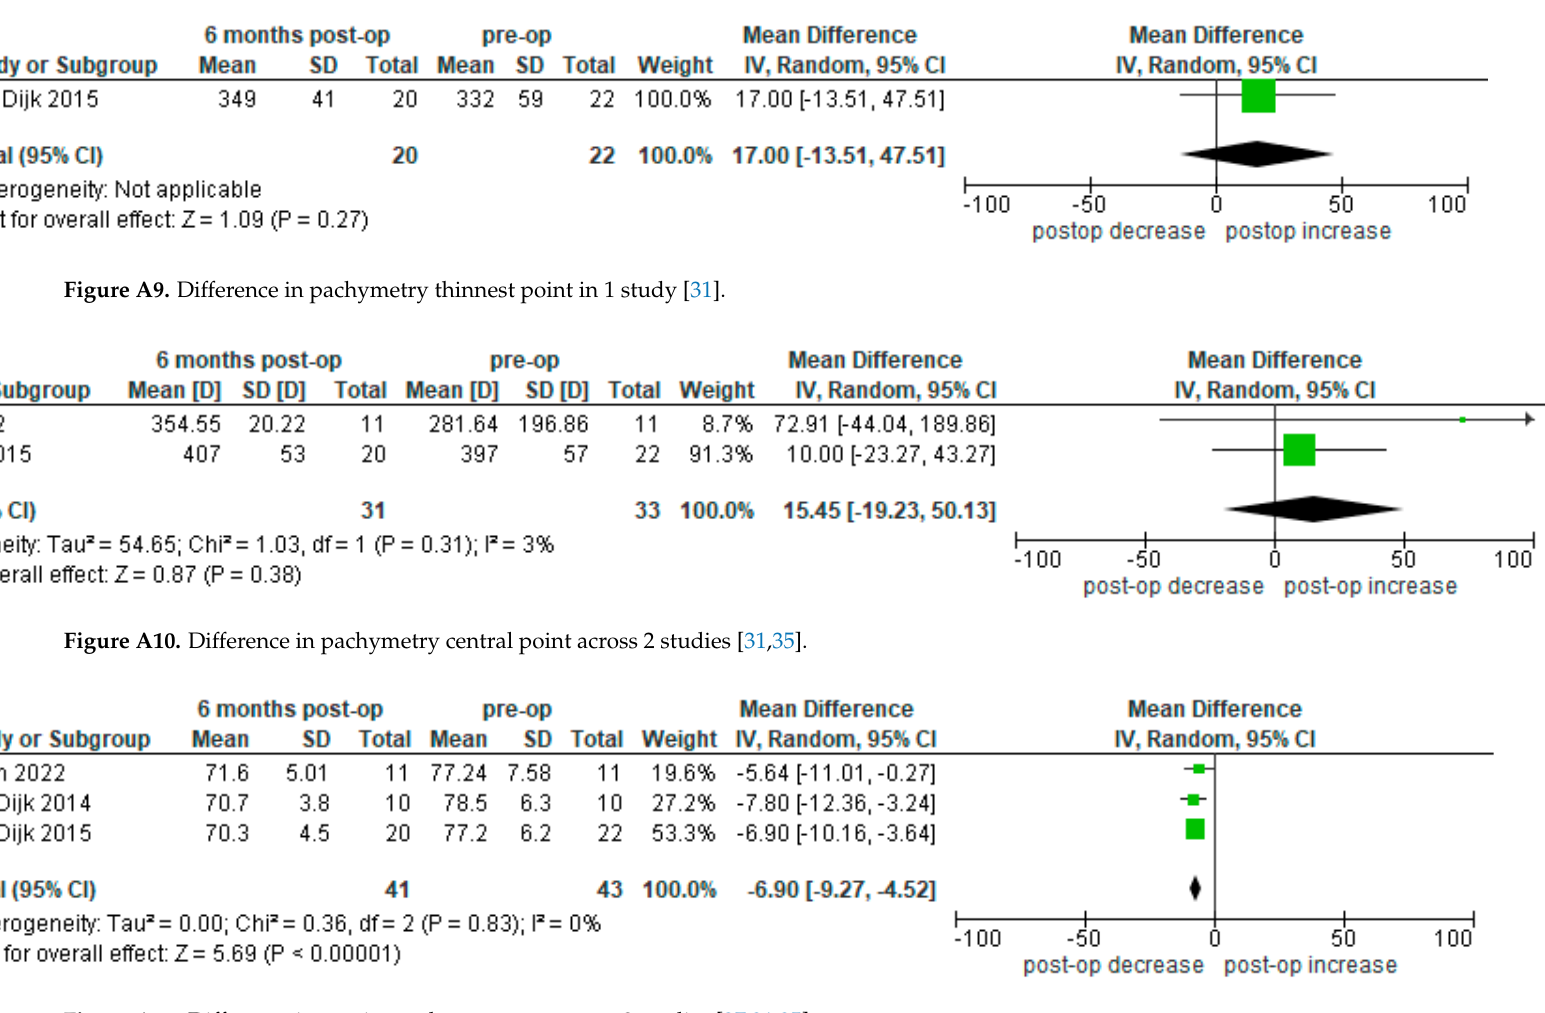
Figure A11. Di ff erence in maximum keratometry across 3 studies [27,31,35].